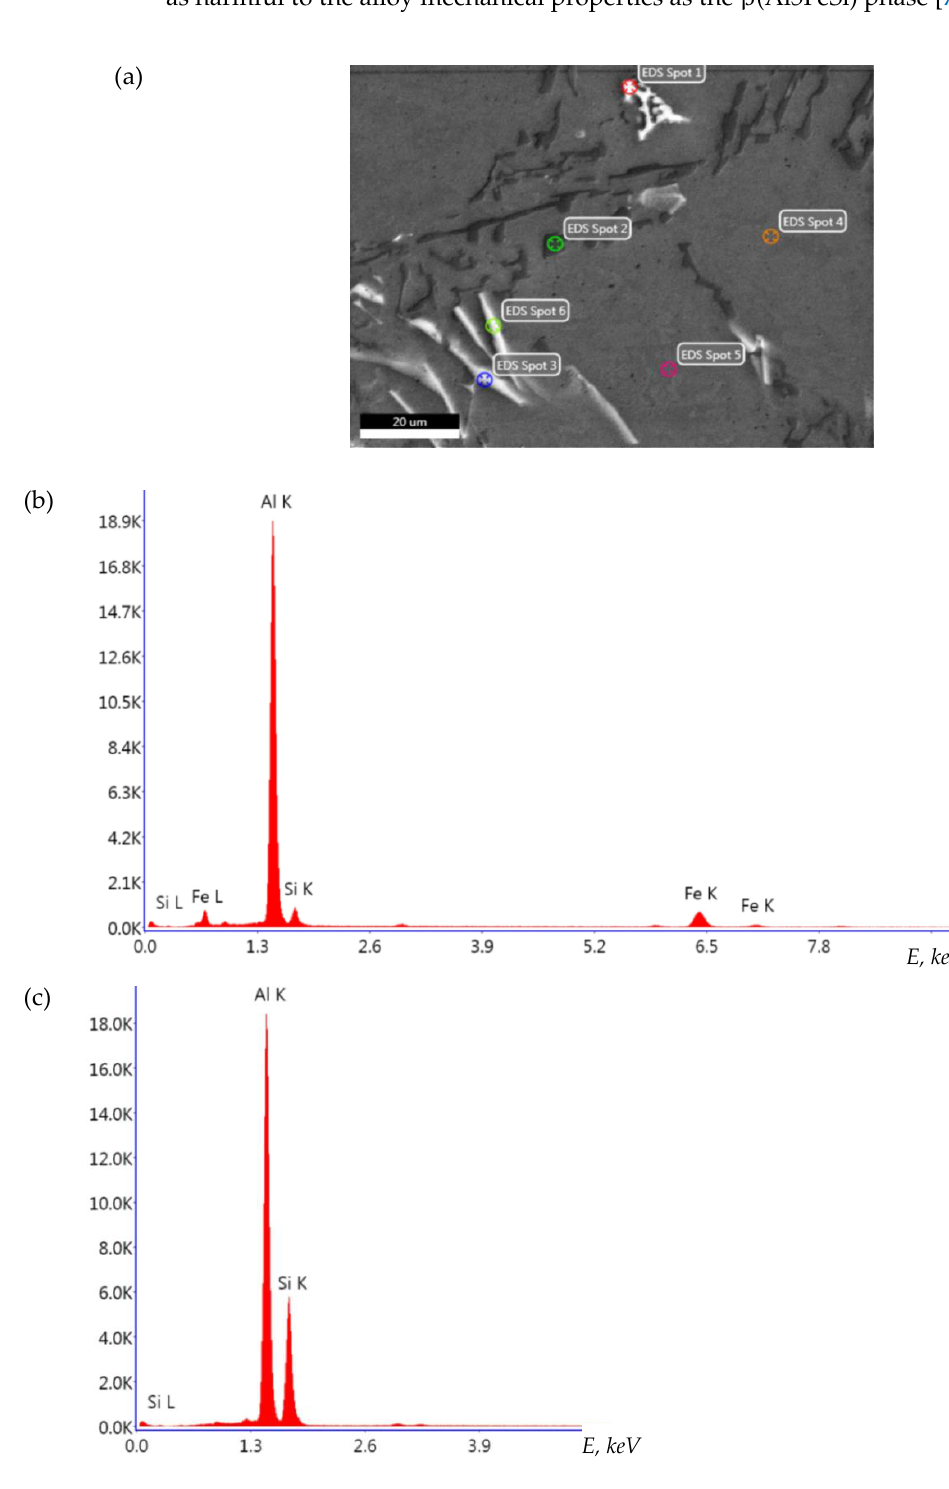
Figure 11. Effects of the T6 heat treatment parameters on impact strength KC of the EN AC – AlSi11(Fe) alloy for determined ( a ) t s = 280 °C, τ s = 5 h, ( b ) t p = 545 °C, τ p = 2.5 h.